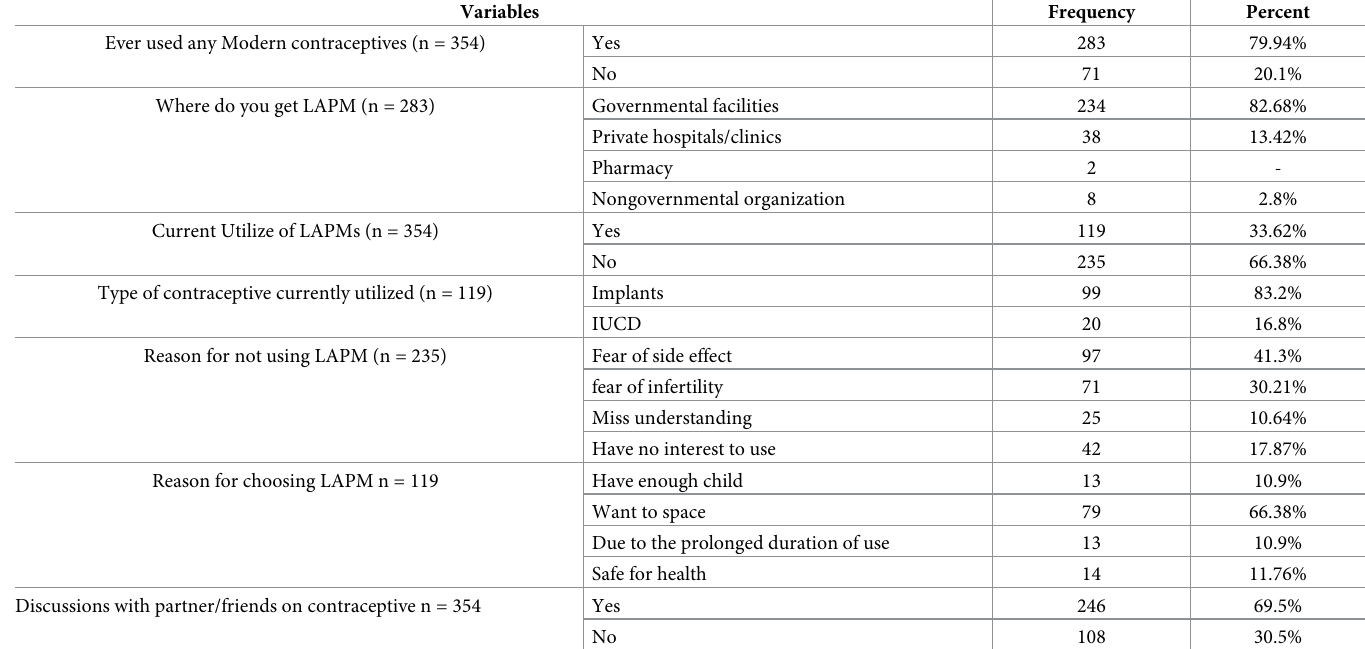
Table 6. LAPMs utilization practice in South Wollo zone hospitals, March, 2021, n = 354.